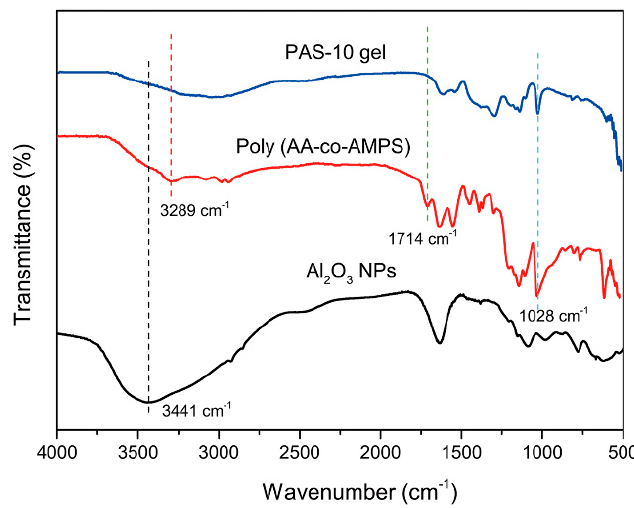
Figure 2. Fourier transform infrared (FT-IR) spectra of Al 2 O 3 NPs, neat copolymer of acrylic acid (AA) and 2-acrylamido-2-methylpropane sulfonic acid (AMPS), and PAS-10 gel.